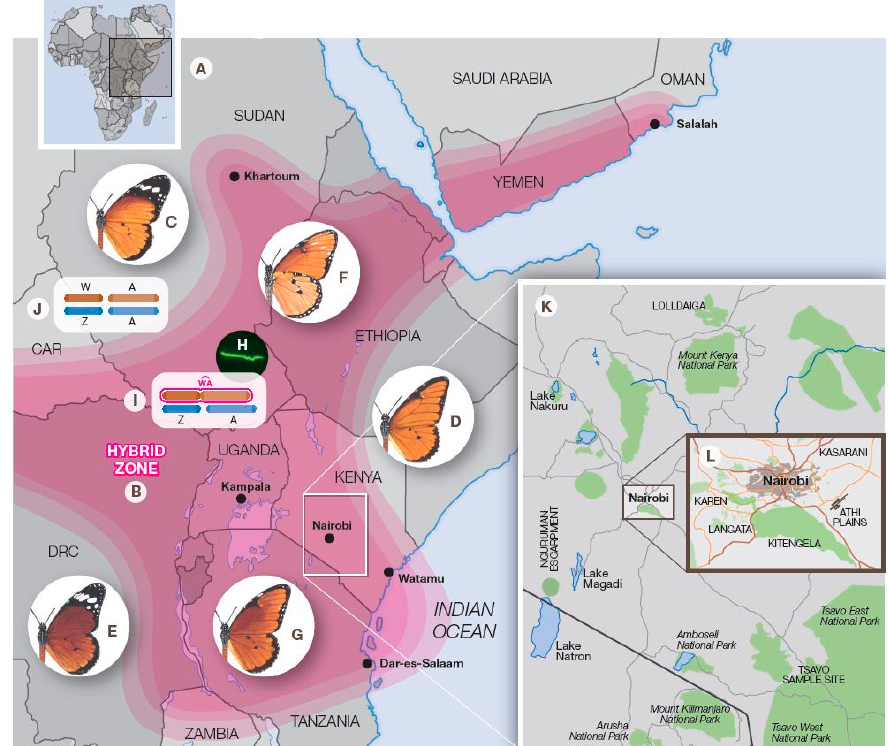
Figure 6. Map of Africa ( A ) showing the location of samples, approximate boundaries of the hybrid zone ( B ), and distribution outside the hybrid zone of subspecies chrysippus ( C ), dorippus ( D ) and orientis ( E ). Hybrid forms transiens (underside) ( F ) and klugii ( G ) are confined to the hybrid zone, as are the endosymbiont Spiroplasma ixodetis ( H ) and the fused neo-W karyotype (2 n = 59) ( I ). Outside the hybrid zone the wild-type unfused karyotype (2 n = 60) of all subspecies is shown in ( J ). Sampling sites mentioned in the text are shown in the insets, southern Kenya ( K ) and the environs of Nairobi ( L ). Acronyms: CAR = Central African Republic; DRC = Democratic Republic of Congo. Abbreviations: A, autosome (neoZ or Z 2 in I), W, W chromosome; Z, Z chromosome (Z 1 in I).